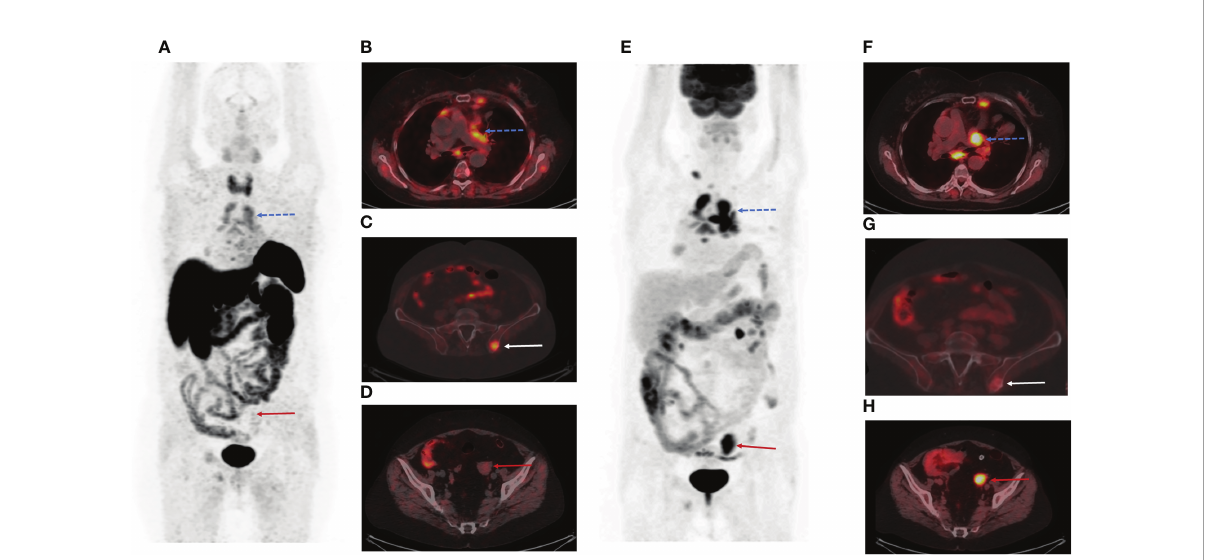
FIGURE 1 Positron emission tomography/computed tomography (PET/CT) images with Gallium-68 [68Ga]-labeled dodecanetetraacetic acid-tyrosine-3- octreotate ([68Ga]-DOTA-TATE) and Fluor-18 [18F]- fl uorodeoxyglucose ([18F]-FDG). (A) The maximum intensity projection (MIP) images summarize the physiological and pathological distribution of [68Ga]-DOTA-TATE in the body. (B) PET/CT scan showed multiple mediastinal lymphatic nodes (blue dotted arrow) and widespread bone metastases with signi fi cant uptake of [68Ga]-DOTA-TATE. (C) [68Ga]-DOTA-TATE-positive bone metastasis in the left iliac wing (white arrow). (D) [68Ga]-DOTA-TATE-negative solid mass in the left ovary (red arrow). (E) The MIP images summarize the physiological and pathological distribution of [18F]-FDG in the body. (F) Multiple [68Ga]-DOTA-TATE-positive metastases in mediastinal lymphatic nodes (blue dotted arrow). (G) The axial PET/CT image demonstrated low [18F]-FDG uptake in the bone metastasis in the left iliac wing (white arrow). (H) The axial slice